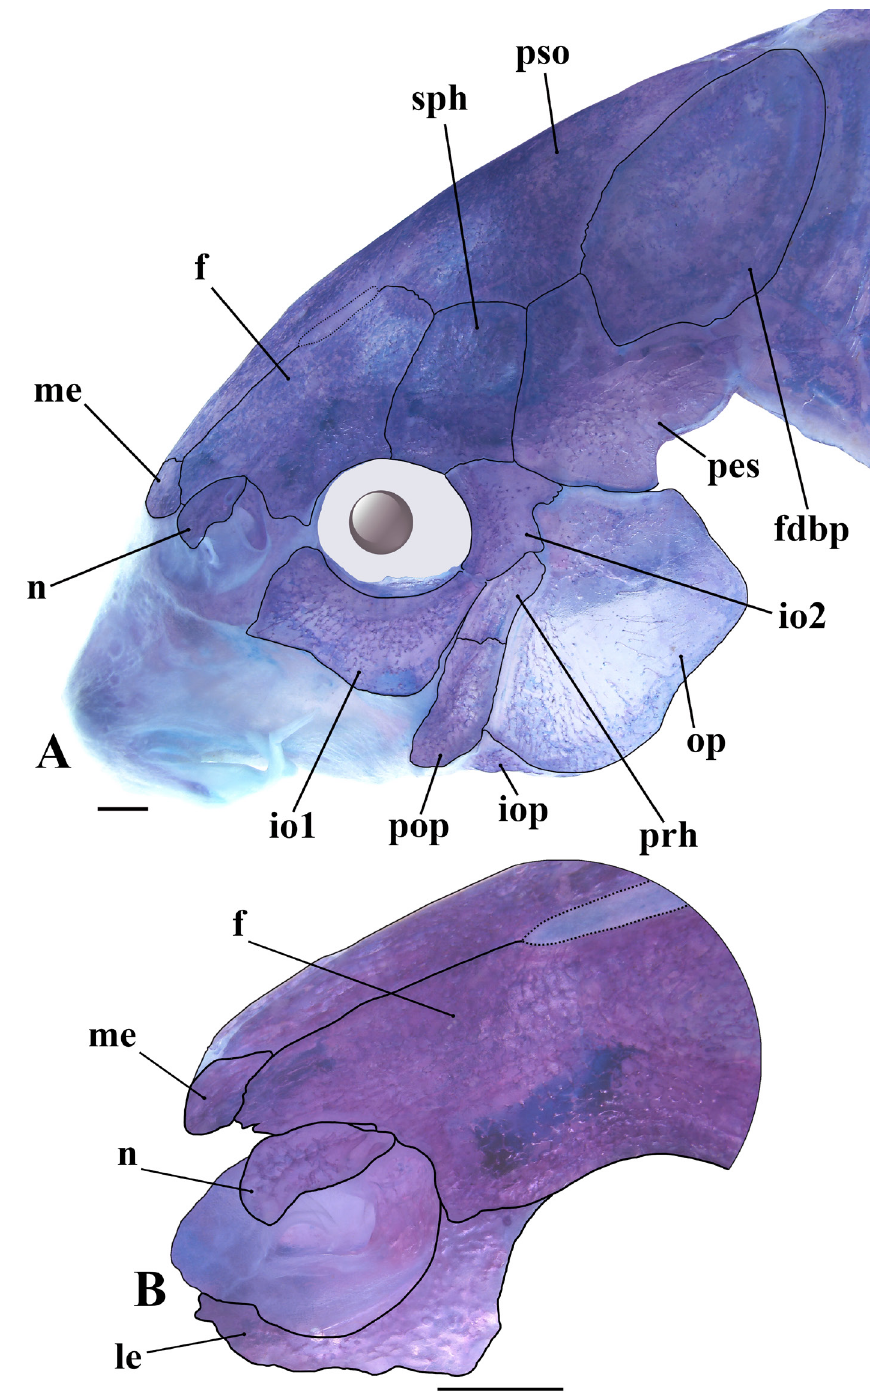
FIGURE 2 | Head osteological pattern in c&s paratypes of Corydoras maclurei , showing ( A ) general morphology in lateral view (CITL 430, 47.8 mm SL), with ( B ) the detail of the lateral ethmoid morphology (CITL 430, 38.2 mm SL). Abbreviations: f: frontal, fdbp: first dorsolateral body plate, io1–2: infraorbital 1 and 2, iop: interopercle, le: lateral ethmoid, n: nasal, me: mesethmoid, op: opercle, pes: pterotic- extrascapular, pop: preopercle, prh: posterodorsal ridge of hyomandibula, pso: parieto-supraoccipital, sph: sphenotic. Scale bar = 1